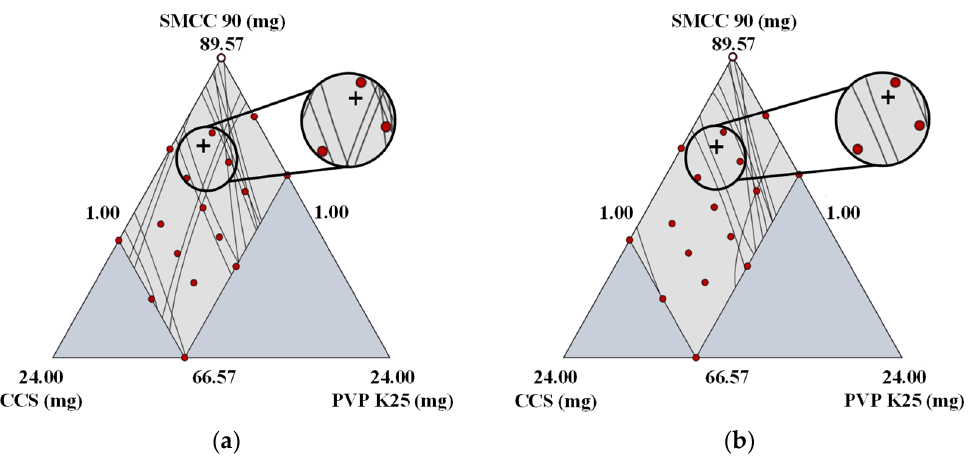
Figure 6. Design space variability triggered by modifications of the grade; ( a ) Design space using D13; ( b ) Design space using D15. The crosshair indicates the optimal setting of formulation development. (SMCC, silicified microcrystalline cellulose; CCS, croscarmellose sodium; PVP, polyvinylpyrrolidone).